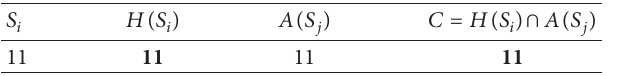
Table 4: The third Reachable Set and Antecedent Set in reduced matrix H 2